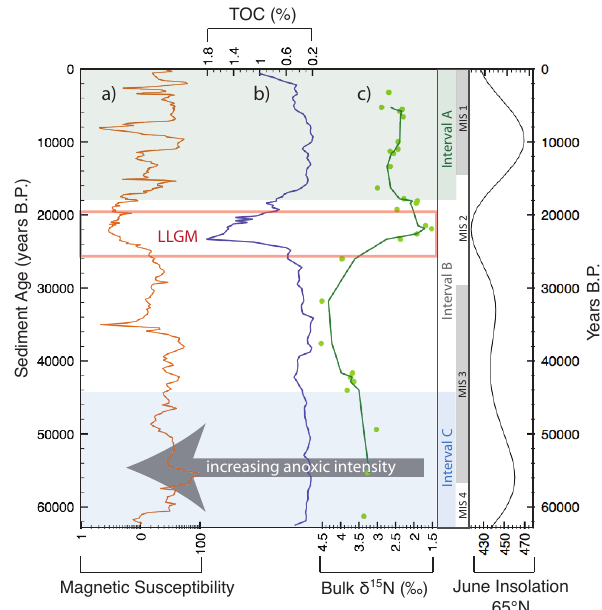
Fig. 4. (a) Magnetic susceptibility (Murdock et al., 2012) relative to (b) TOC (Murdock et al., 2012) and (c) bulk δ 15 N. Green line denotes 3-point running mean. Note that the x-axis scale for TOC is reversed. Summer insolation at 65 ◦ N is shown (Berger and Loutre, 1991). The orange box denotes